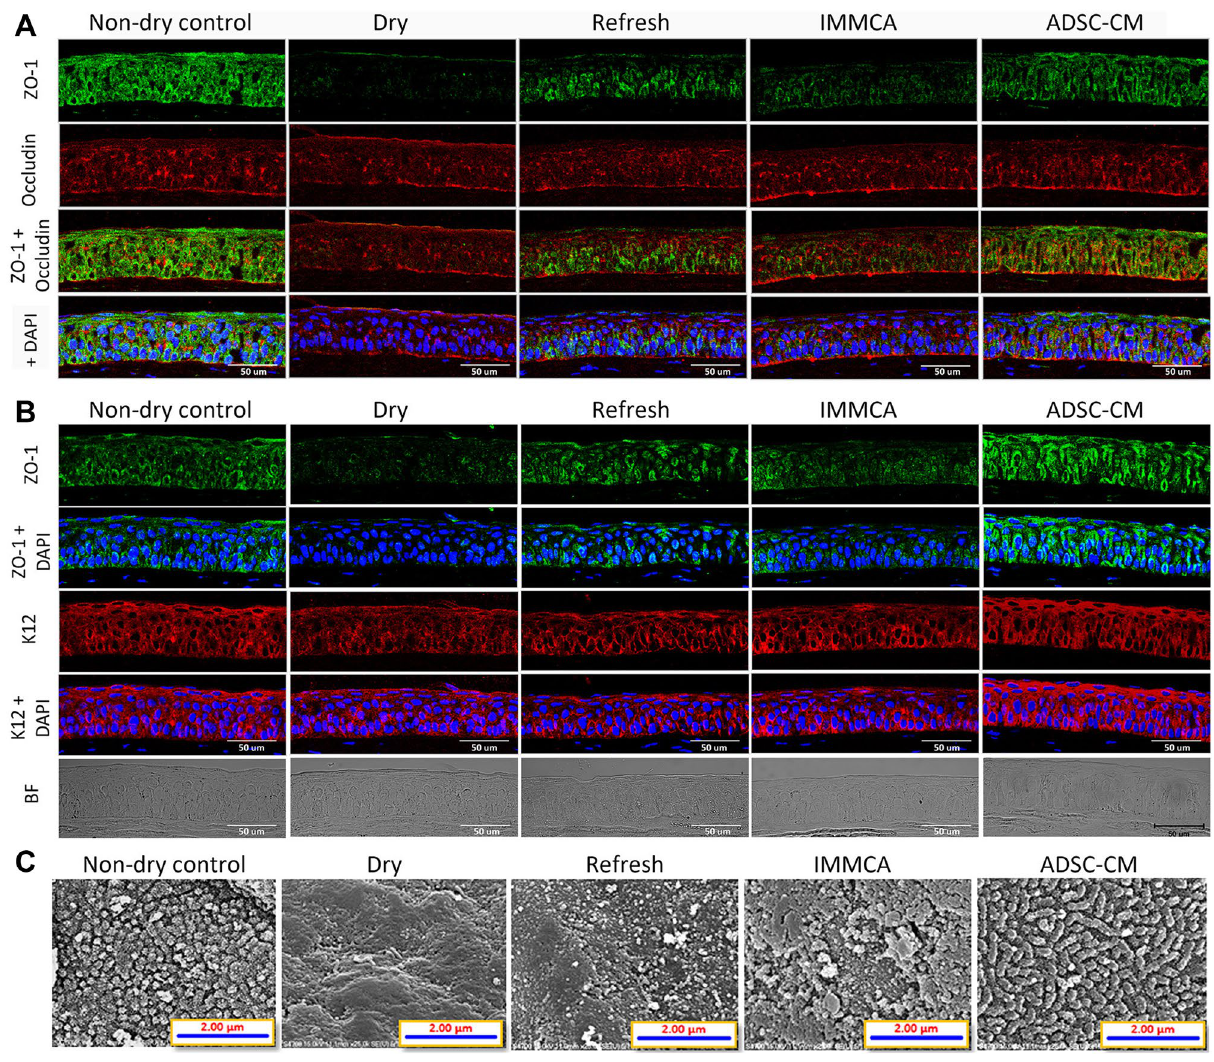
Figure 1. Confocal microscopic examination of the tight junction and scanning electron microscopy of corneal epithelium of BALB/c mice in the controlled-environment chamber (CEC)-induced dry eye model. (A) ZO-1 and occludin expression was suppressed in the BALB/c mice from CEC. Although topical application of Refresh Plus lubricant eye drops or IMMCA alleviated the suppressed expression caused by dry stress, ADSC-CM showed the best rescue. (B) In another experiment, ZO-1 and K12 expressions were also suppressed by dry stress, and the best expression was demonstrated in the ADSC-CM group. (C) Scanning electron microscopy of cornea demonstrated that the microvilli of corneal epithelium were lost in the dry eye mice. Topical application of Refresh Plus lubricant eye drops or IMMCA partially preserved the microvilli of corneal epithelium, while ADSC-CM protected the microvilli best from dry damage. Magnification: microvilli was about 50 to 60% in the groups treated with Refresh Plus lubricant eye drops or IMMCA, while that in the ADSC-CM group was similar to that in the non-dry control group. ADSC-CM protected not only the tight junction of corneal epithelial cells but also the conjunctival goblet cells and the membrane-associated mucin Muc16 expression. Conjunctival goblet cell density was an ocular biomarker of dry eye 89 . Muc16 was one of the major membrane-associated mucins expressed on the ocular surface epithelium 90 . Although Muc16 was expressed only in the conjunctival epithelia in mice 91 , in contrast to both the corneal and conjunctival epithelia in humans 92 , the loss of Muc16 in the conjunctiva affected the homeostasis of the corneal epithelium and stroma and upregulated the inflammatory signaling cascade 93 . In our study, the goblet cell density was decreased in the CEC mice, which was alleviated by Refresh Plus lubricant eye drops, IMMCA, or ADSC-CM. ADSC-CM protected the goblet cells density best to the level similar to that of non-dry mice. The Muc16 expression was continuous in the non-dry group and interrupted in the dry control group. ADSC-CM preserved the integrity of Muc16 expression from dry injury. HCEC desiccation stress and hyperosmolarity stress are two widely used in vitro models to simulate dry eye conditions 55,94–100 . In the HCEC desiccation stress study, ADSC-CM showed better protective or regenerative effect than the commercial corneal epithelial basal medium CEM, with the fractions of < 30 kD, < 10 kD, and < 3